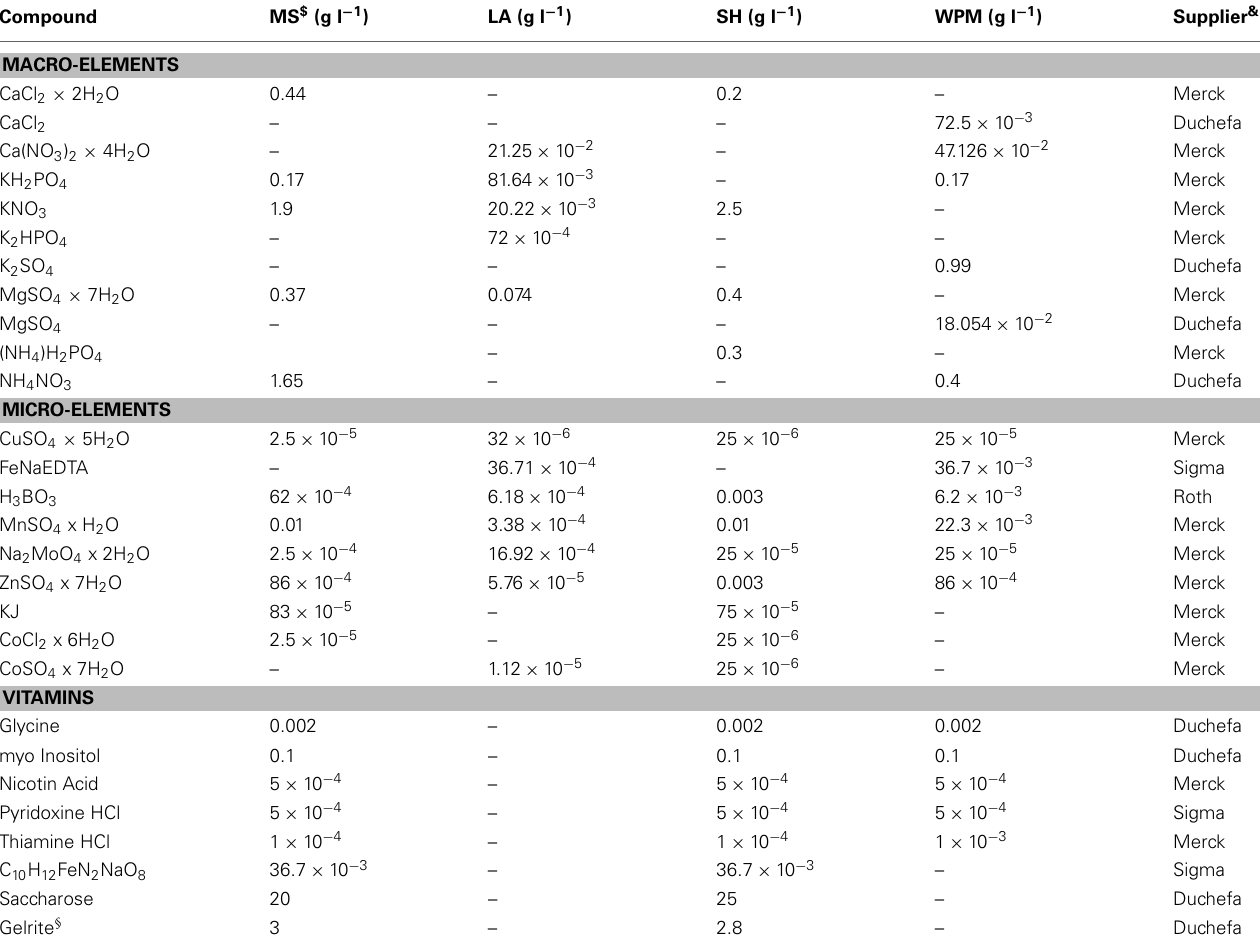
Table 2 | Composition of Murashig & Skoog (MS), Long Ashton (LA), Schenk Hildebrandt (SH), and Woody Plant Medium (WPM) for multiplication and rooting of poplar